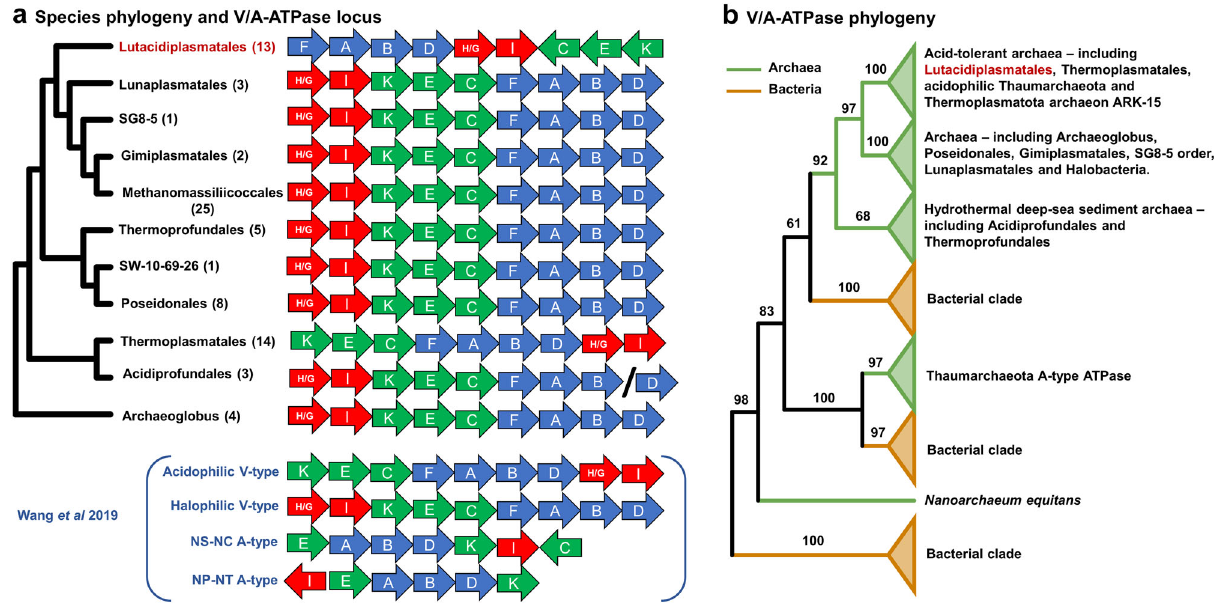
Fig. 6 V/A-type ATPase locus gene order and phylogeny. a The gene order of V/A-type ATPase genes is conserved at the order level and broadly conserved at the phylum level, except for Thermoplasmatales and Lutacidiplasmatales. The tree indicates the phylogeny of the species in which these loci are found. Four gene orders presented in Wang et al. 2019 29 are shown in parenthesis for comparison. The arrow colour indicates genes that tend to be adjacent in all gene orders and is added for comparison. b The ML tree of the three largest subunits ( atp A, B and I) concatenated. Numbers on branches represent the percentage of UFBoot support. The tree was rooted by minimal ancestral deviation (MAD) 91 . The expanded atp ABI tree is presented in Supplementary Fig.